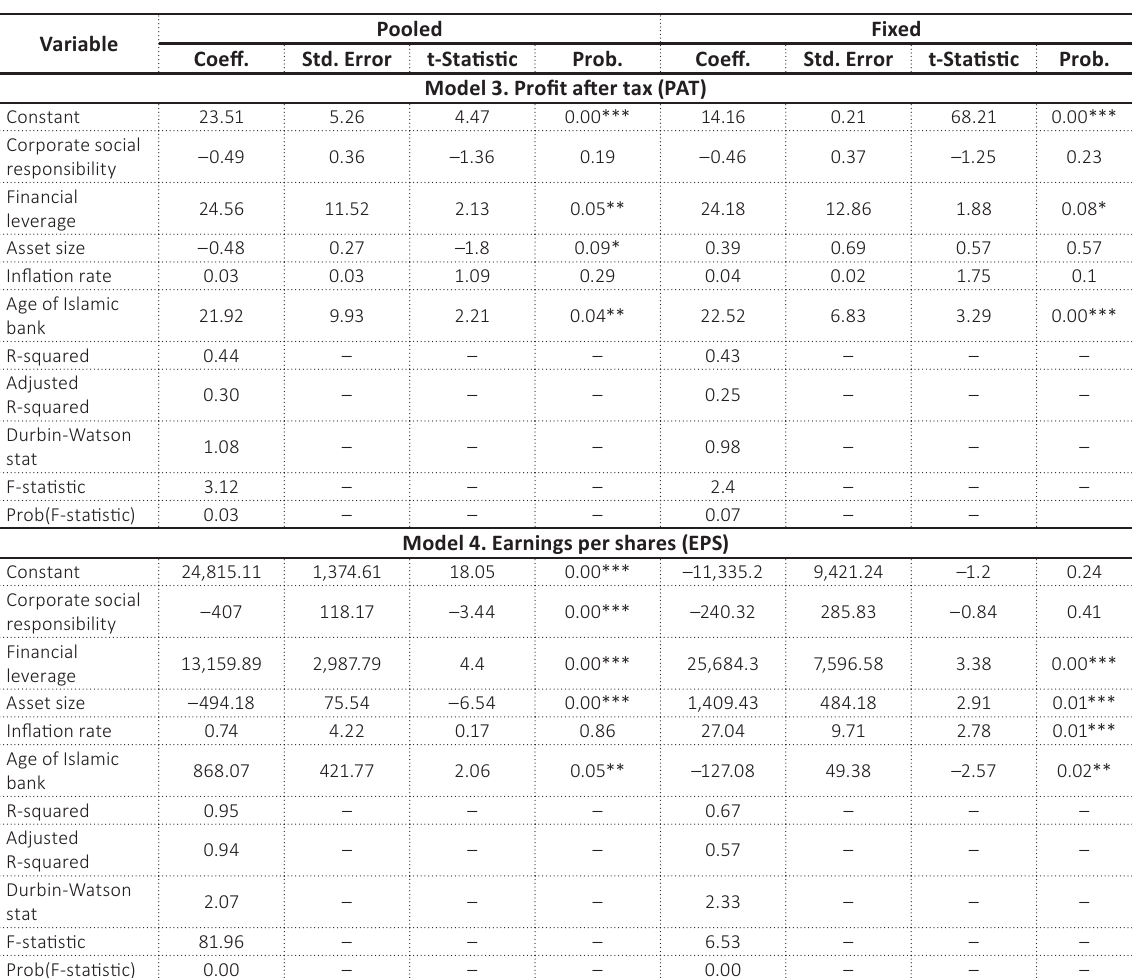
Table 6. PAT and EPS